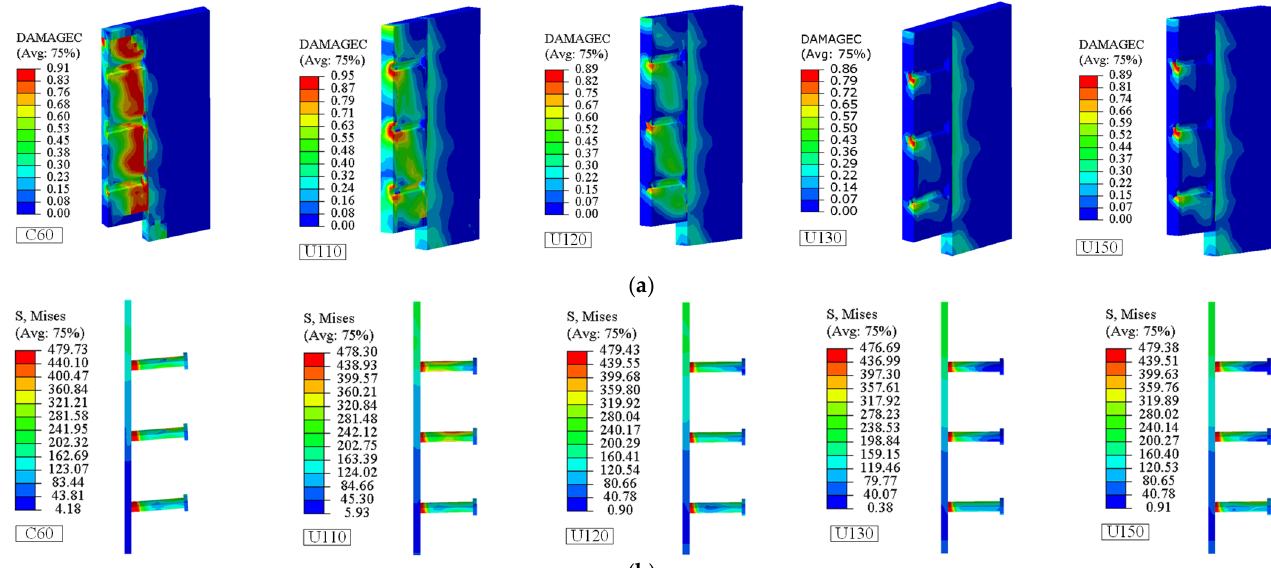
Figure 27. Influence of compressive strength of connection concrete on ultimate strength and shear stiffness.